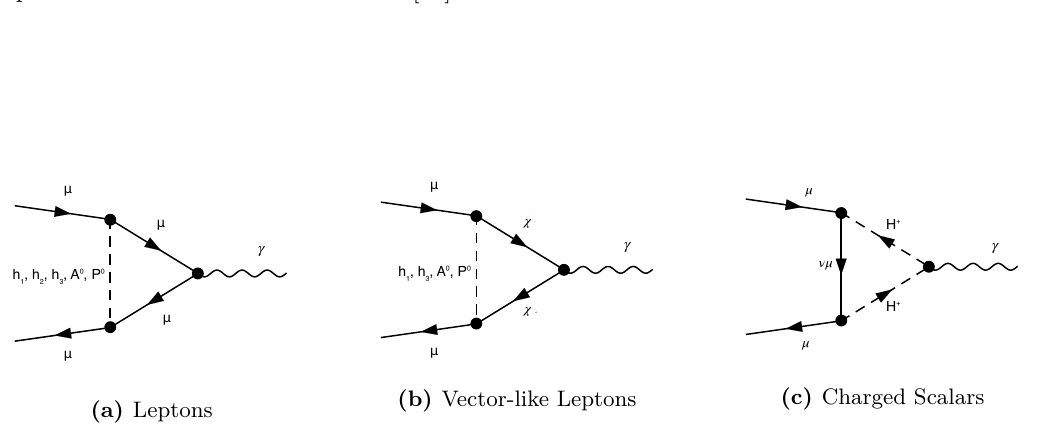
Figure 6. Dominant diagrams contributing to muon g − 2 at one-loop